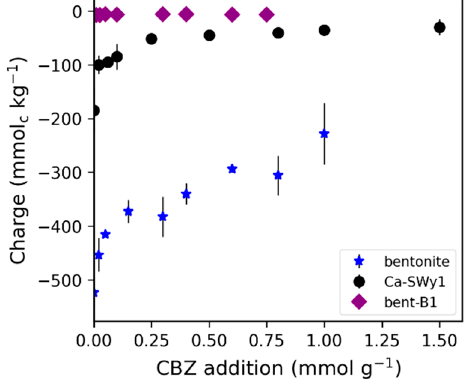
Figure 2. Colloidal charge of bentonite (blue asterisk), Ca-SWy1 (black circle), and bent-B1 organoclay (purple diamond) at 0–1.5 mmol g − 1 CBZ addition.